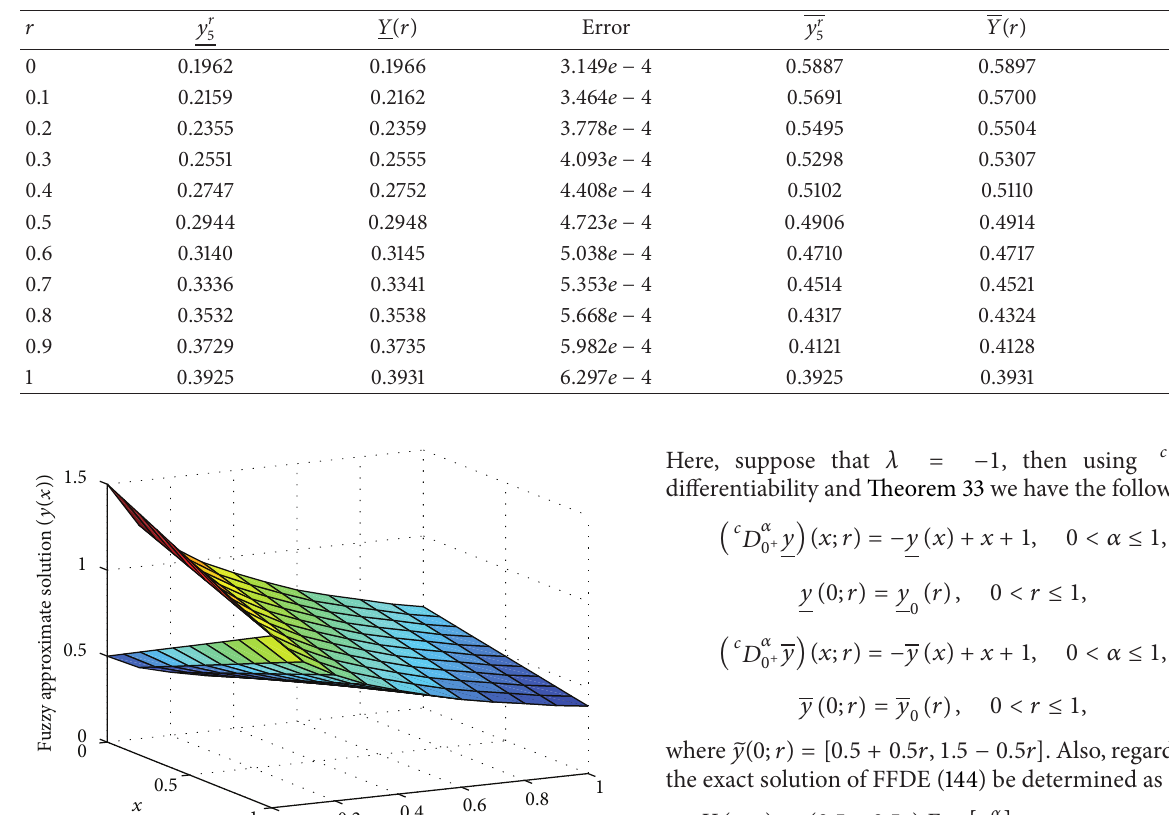
Table 2: The result of the proposed method for Case 2 of Example 52 with 𝛼 = 0.75 and 𝑚 = 9 .